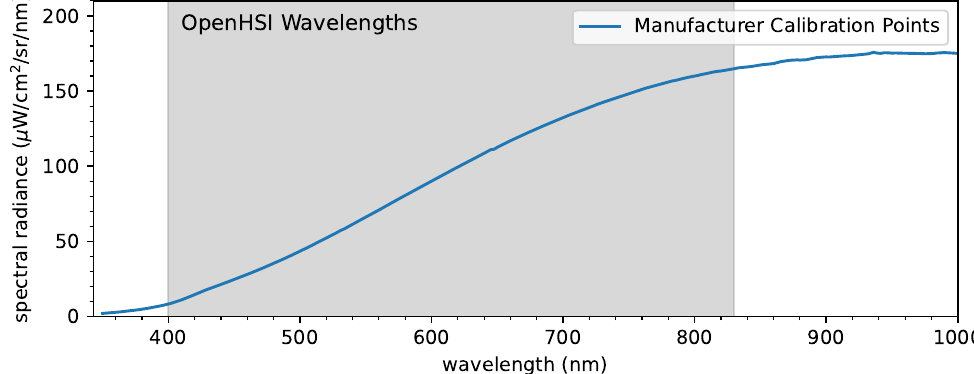
Figure 14. Radiance reference curve taken at 53,880 Cd/m 2